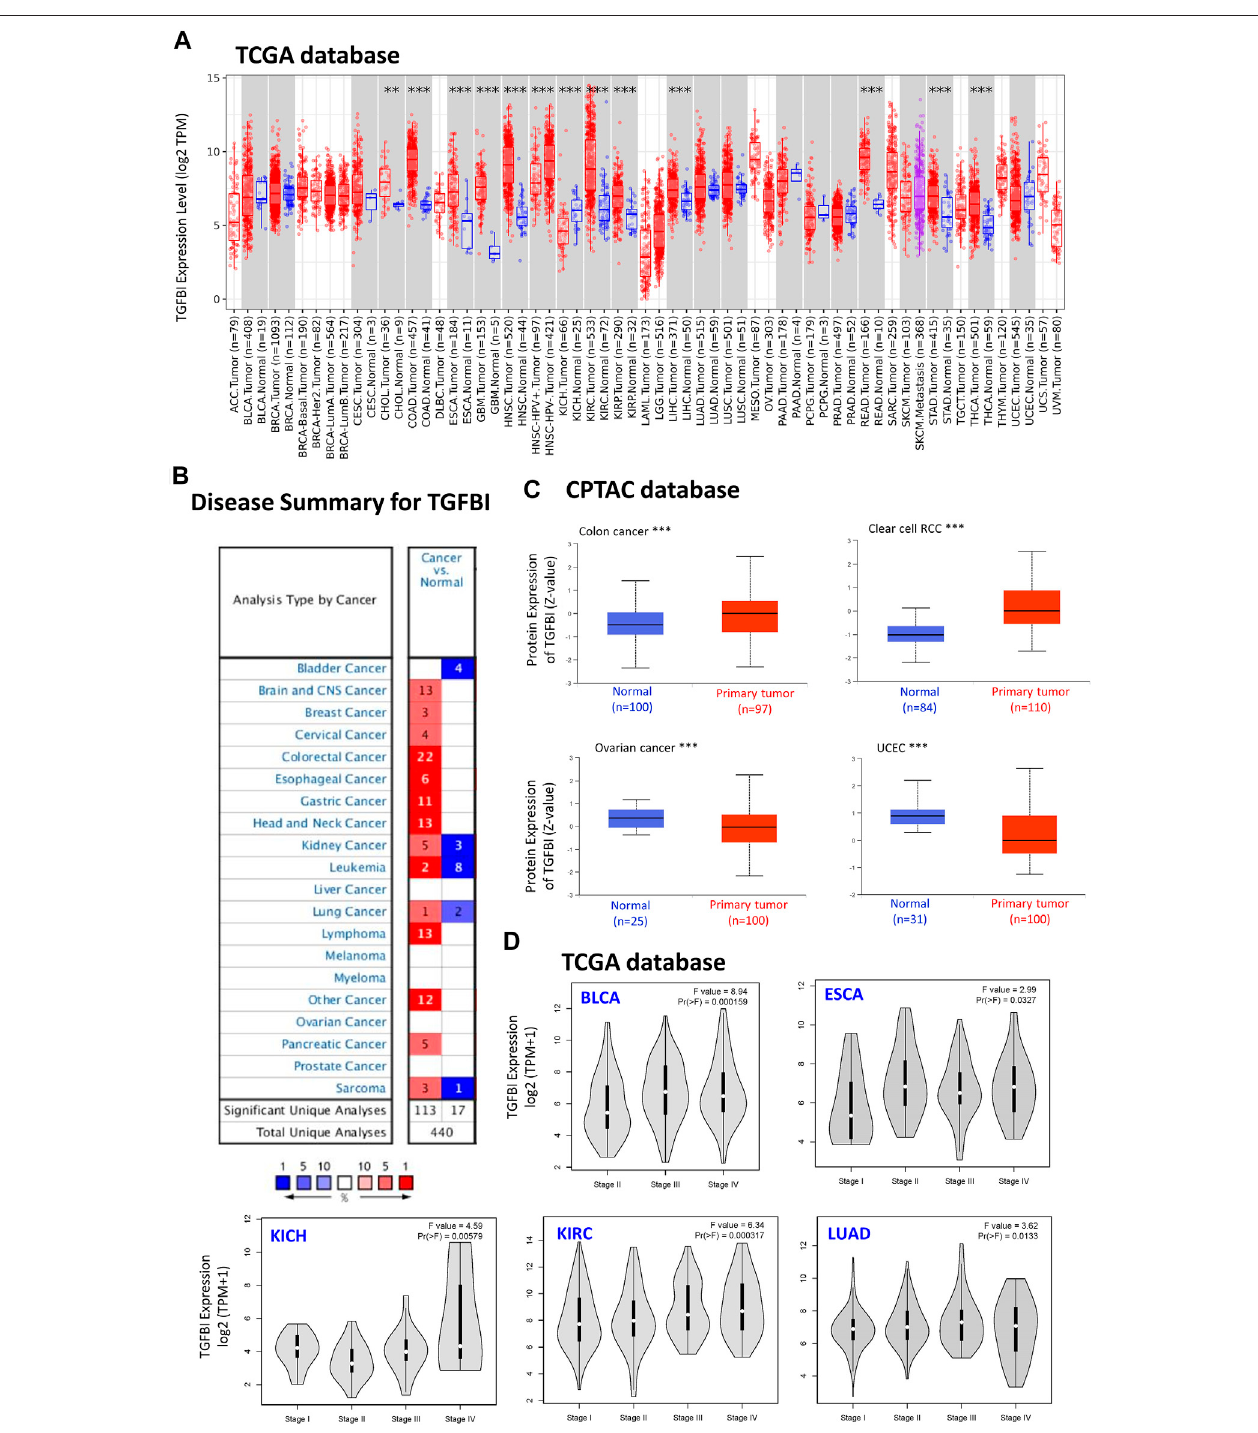
FIGURE 1 | TGFBI expression in various types of human cancers and pathological stages. (A) Comparison of TGFBI expression between various cancers/cancer subtypes and normal tissues using TIMER2 based on TCGA data. * p < 0.05; ** p < 0.01; *** p < 0.001. (B) Comparison of TGFBI expression between various cancer tissues and normal tissues in the Oncomine database. Blue represents low expression of TGFBI in the cancer tissues, red represents high expression, and gray represents no data. The number represents the number of studies that meet the fi lter criteria. (C) Comparison of TGFBI protein expression between primary colon cancer, clear cell renal cell carcinoma, uterine corpus endometrial carcinoma, and ovarian cancer tissues and normal tissues, based on CPTAC data. *** p < 0.001. (D) TGFBI expressioninpathologicalstagesI,II,III,andIVinBLCA,CESC,KICH,KIRC,andLUAD,basedonTCGAdata.Thedataweretransformedusinglog2(transcripts per million [TPM] + 1). F represents the statistical value of F test, Pr( > F) < 0.05 was considered signi fi cant.